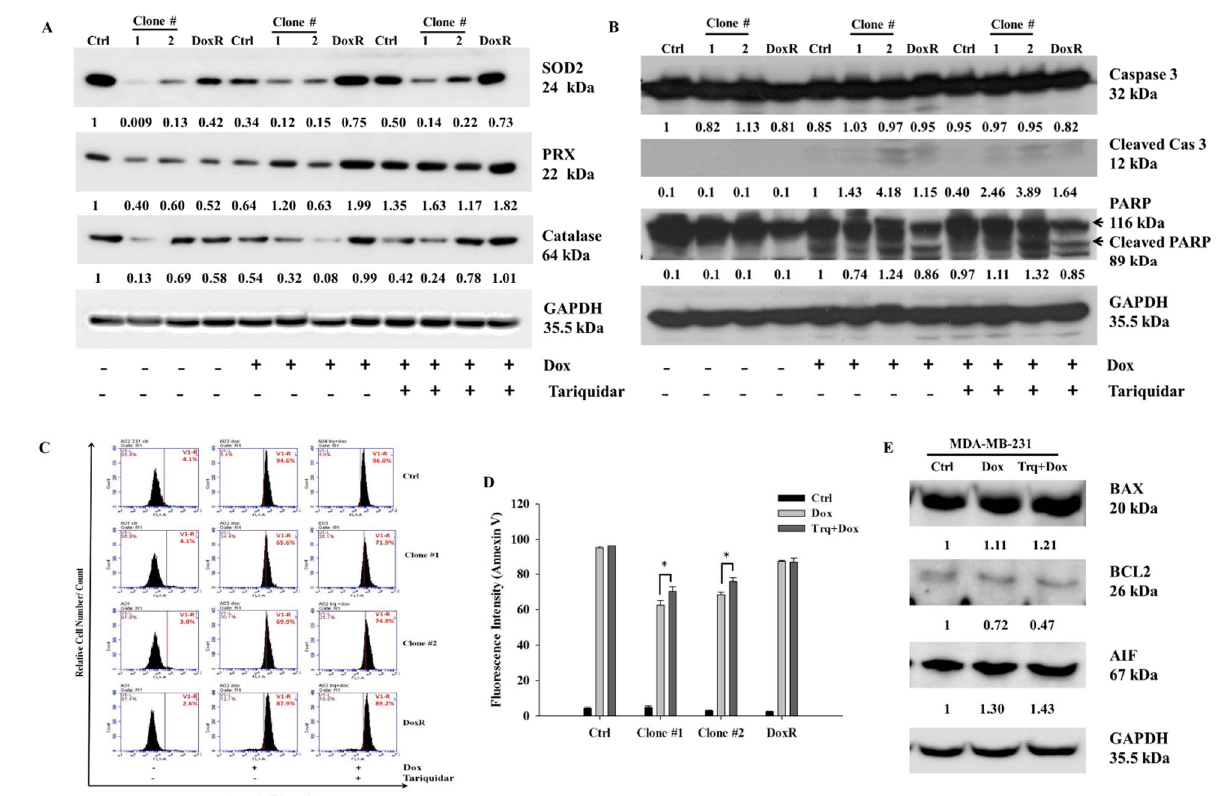
Figure 6. Representative and quantitative results of cell death mechanism in Dox and Tariquidar + Dox treated control and DEHP exposed MDA-MB-231 cells. ( A , B ) Western blot results show the upregulation of ROS markers, SOD2, PRX, and catalase along with apoptosis markers cleaved caspase 3 and cleaved PARP by Dox and tariquidar-Dox treatment (2 µ M, 48 h) in control and DEHP-exposed clones #1 and #2. ( C , D ) Representative and quantitative results of the Annexin V-FITC apoptosis assay. A high number of Annexin V-positive cells was observed after tariquidar (1.5 µM, 2 h) pretreatment plus Dox (2 µM, 48 h) treatment compared to Dox (2 µM, 48 h) treatment alone in DEHP-exposed clones #1 and #2, as evidenced by BD Accuri TM C6 flow cytometry. ( E ) In parental/control MDA-MB-231 cells, Dox and tariquidar-Dox treatment (2 µ M, 48 h) upregulated BAX and AIF; however, BCL2 was downregulated. The fold change in protein expression from western blots was analyzed by ImageJ 1.42q, NIH, USA. * p < 0.05.